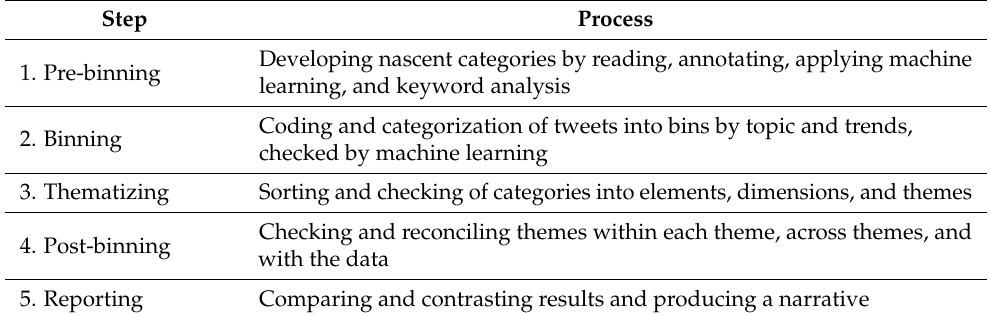
Table 1. Rapid tweet analysis